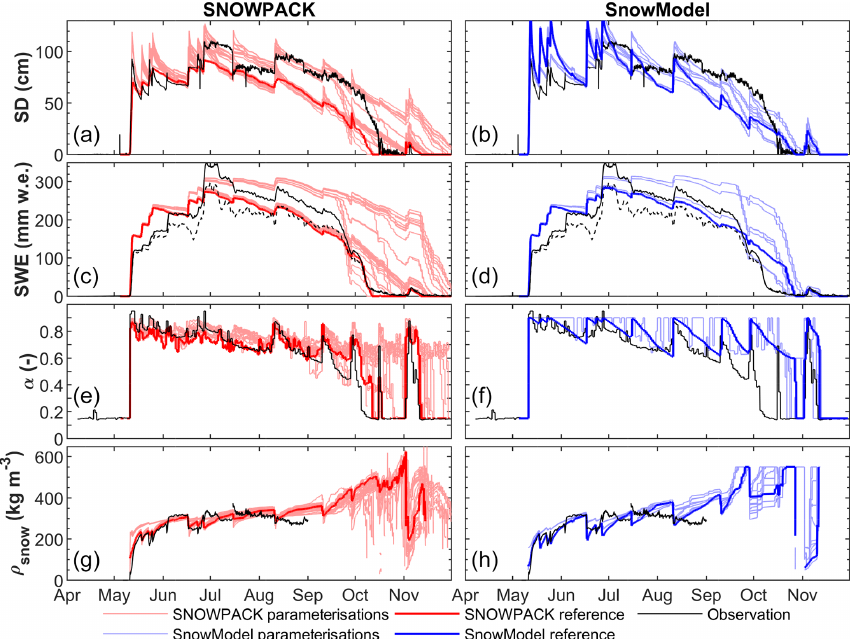
Figure 4. (a, b) SD, (c, d) SWE, (e, f) albedo, and (g, h) snow density simulations (coloured) of the ensemble approaches for SNOWPACK (red), SnowModel (blue), and observations (black). The bold coloured lines show the reference simulations chosen as the most optimal pa- rameterisation set according to the measured albedo. The solid (dotted) line in (c) and (d) indicates the more (less) reliable SWE measurement from potassium (thallium)